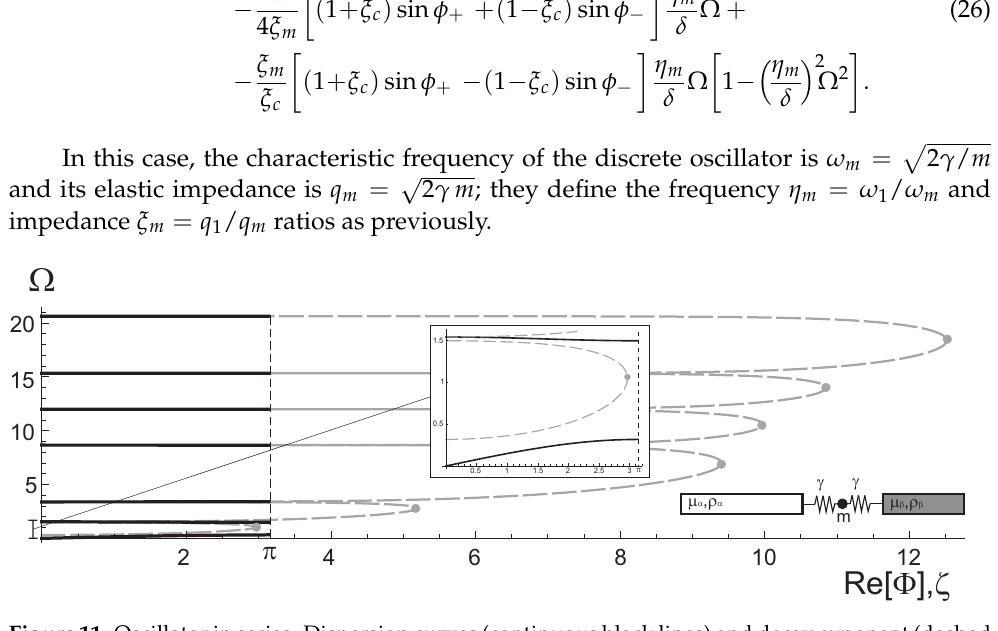
Figure 11. Oscillator in series. Dispersion curves (continuous black lines) and decay exponent (dashed grey lines). Normalised frequency Ω is given for ξ c = 0.22, η c = 0.5, ξ m = 8.71 and η m =